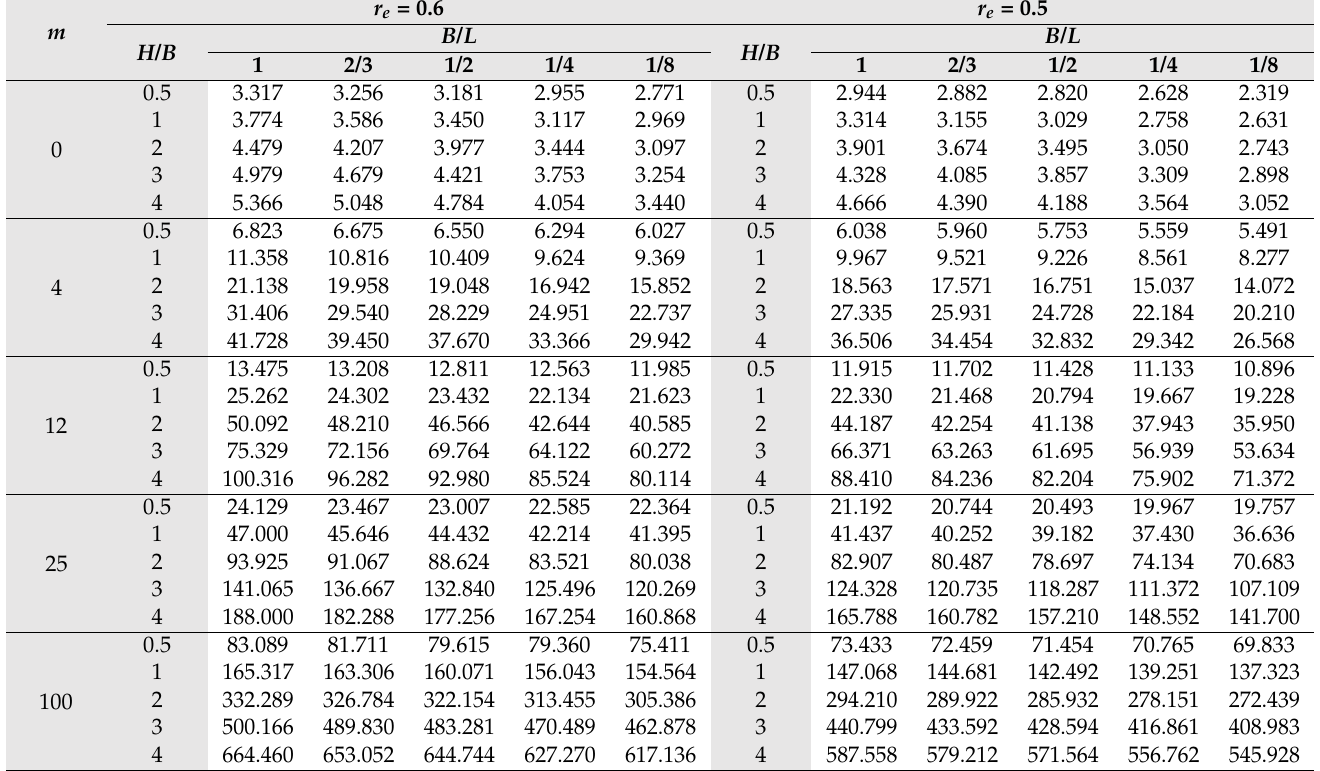
Table 3. Stability numbers, N ( r e = 0.6 and